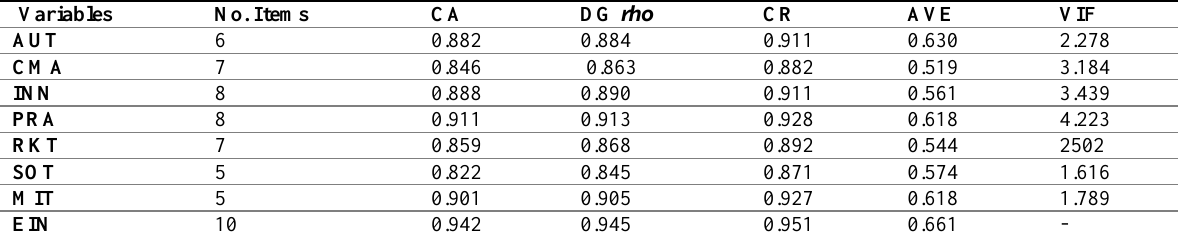
Table 2: Latent constructs reliabilities (Stage 1)